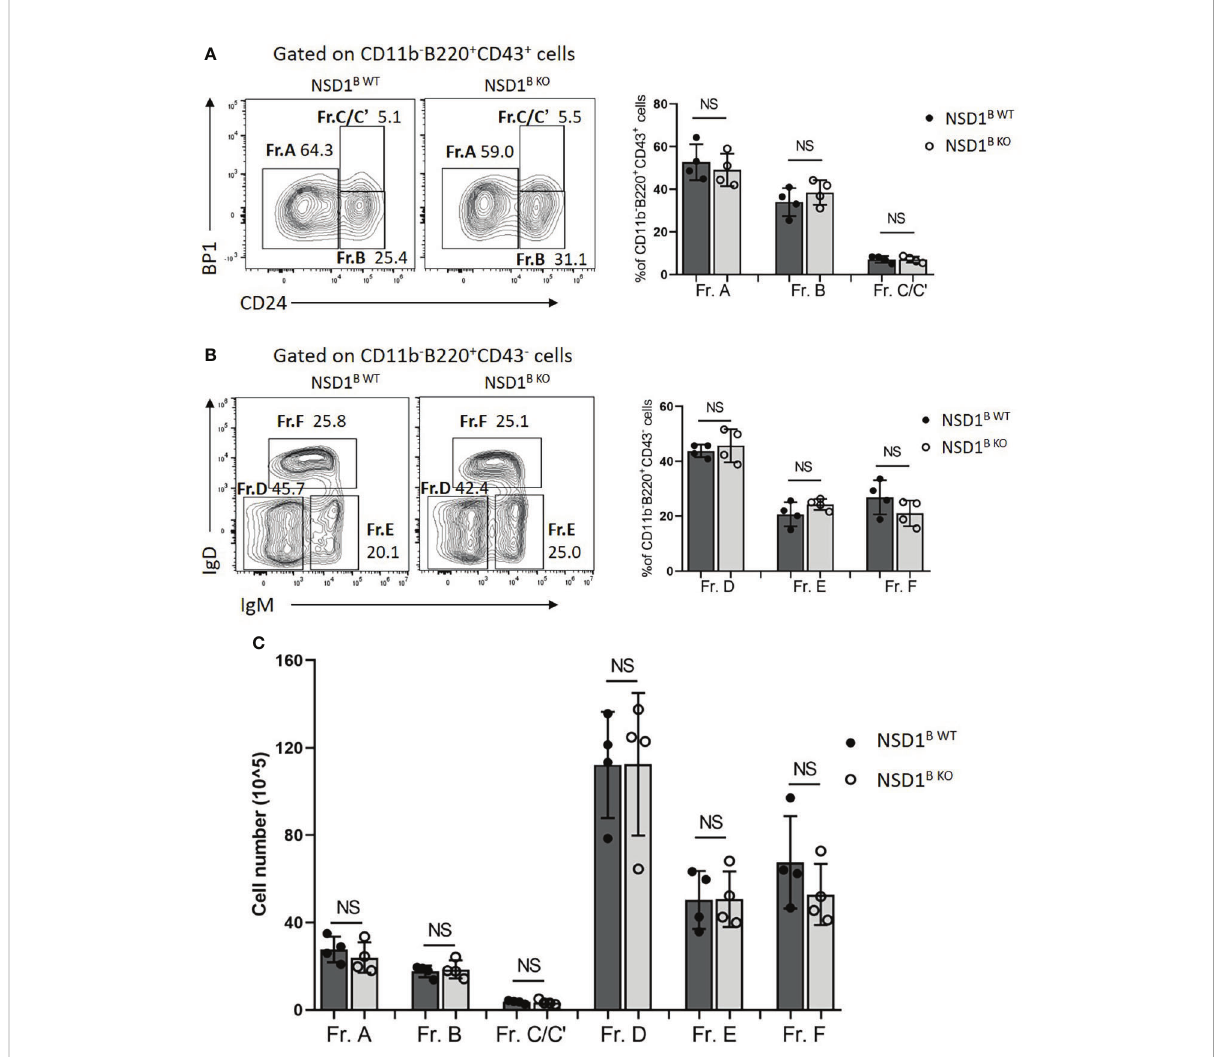
FIGURE 1 Loss of NSD1 did not affect the development of B cells in bone marrow. The development B cell were analysed in the bone marrow from WT (NSD1 B WT ) and NSD1 B cell de fi cient (NSD1 B KO ) mice. (A) . Hardy fractions (Fr. A CD24 - Bp1 - ; Fr. B CD24 + Bp1 - and Fr. C/C ’ CD24 + Bp1 + ) were analyzed in the CD11b - B220 + CD43 + cells. (B) . Hardy fractions (Fr. D IgD - IgM - ; Fr. E IgD + IgM - and Fr. F IgD + IgM + ) were analyzed in the CD11b - B220 + CD43 - cells. (C) . The cell number of Fr. A - F in the bone marrow from the NSD1 B WT and NSD1 B KO mice. (n = 4). NS, no signi fi cant